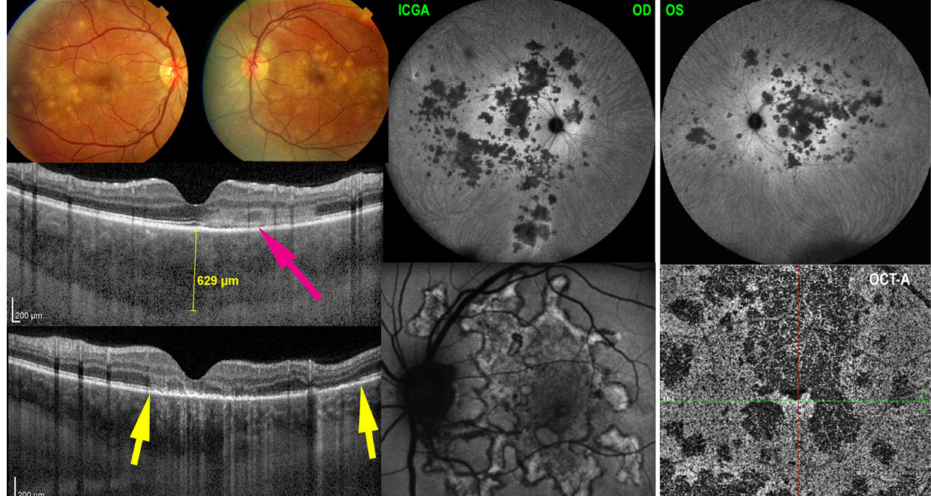
Figure 2. Multimodal imaging signs in APMPPE. Fundus ( top left ) shows numerous bilateral placoid discolored lesions, corresponding to ICGA hypofluorescent choriocapillary non-perfusion lesions ( top right two frames). SD-OCT pictures show alteration and thickening of outer retina (ONL/photoreceptor IS/OS layer middle left picture, crimson arrow) and loss of photoreceptor IS/OS line ( bottom left picture, between the two yellow arrows). BL-FAF shows hyperautofluorescence, indicating loss of photoreceptor outer segments as explained in paragraph 2.1 ( bottom middle picture) OCT-A ( bottom right picture) shows choriocapillary drop-out (dark